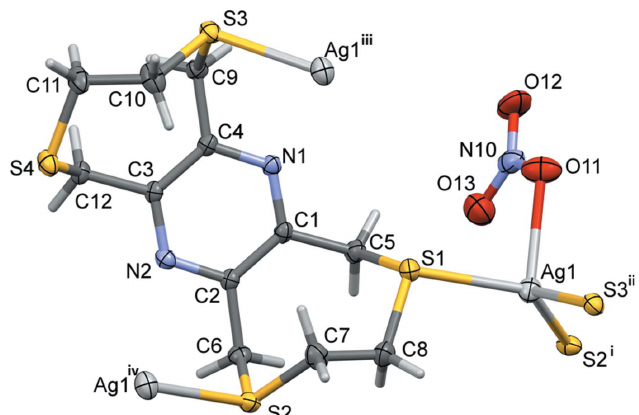
Figure 4 The asymmetric unit of complex II , with atom labelling [symmetry codes: (i) (cid:4) x + 1, y (cid:4) 1 (cid:4) x + 1, y + 1 probability level.